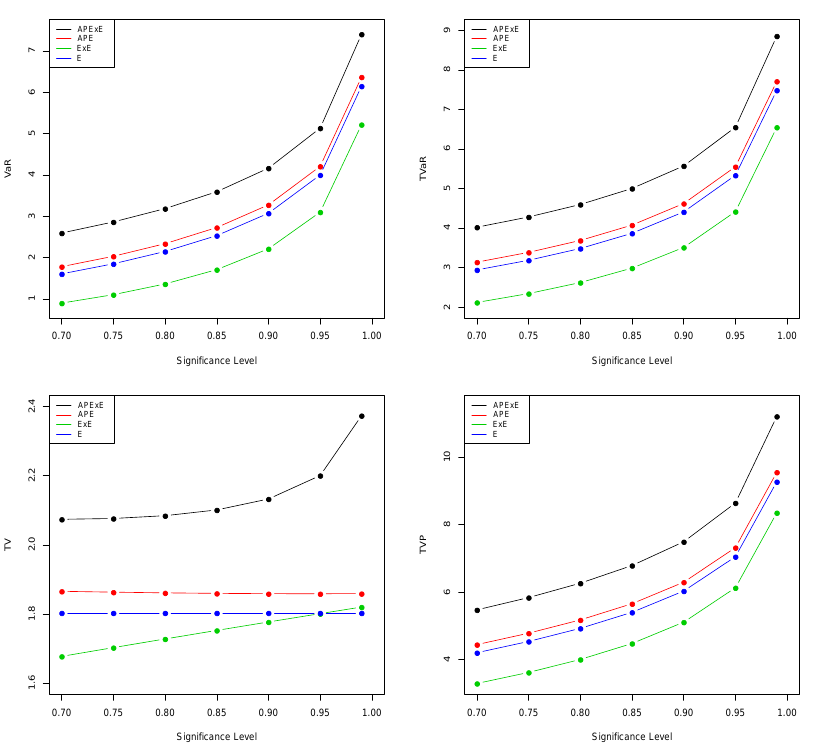
Figure 4. Plots of the VaR, TVaR, TV, and TVP using the values in Table 2.